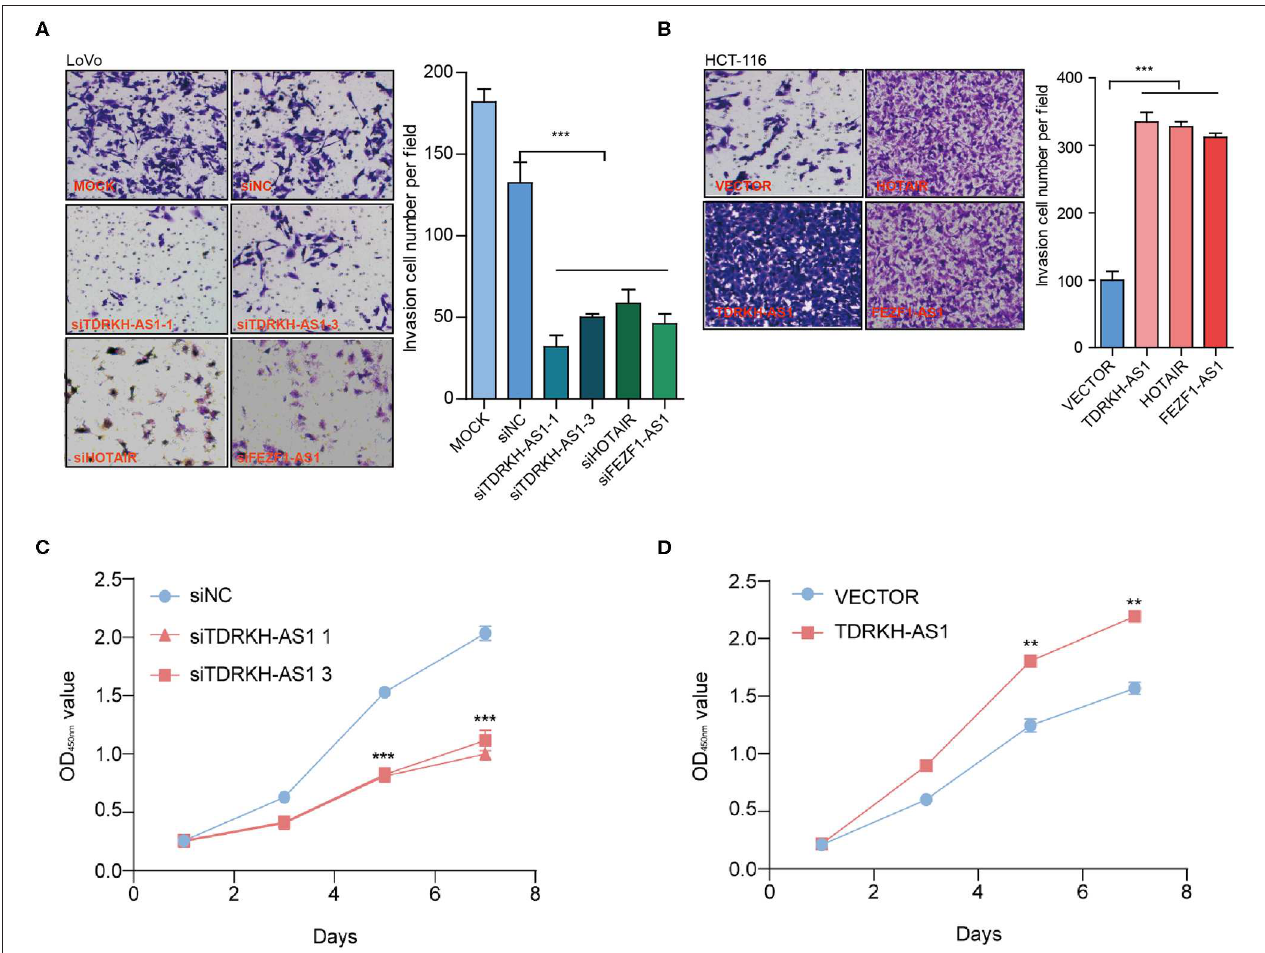
FIGURE 3 | TDRKH-AS1 increases the proliferation and invasion of colorectal cancer (CRC) cells in vitro . (A) Through the Transwell assay, knockdown of TDRKH-AS1 can significantly inhibit the invasion ability of the LoVo cells. (B) Overexpression of TDRKH-AS1 can significantly promote the invasion ability of the HCT-116 cell lines. (C) Knockdown of TDRKH-AS1 significantly inhibited the ability of proliferation of the LoVo cells in the cell counting kit-8 (CCK-8) assay. (D) Overexpression of the TDRKH-AS1 significantly promoted the ability of proliferation in the HCT-116 cell lines. Statistics were considered to be at a significant level when p < 0.05, where * p < 0.05, ** p < 0.01, and *** p <